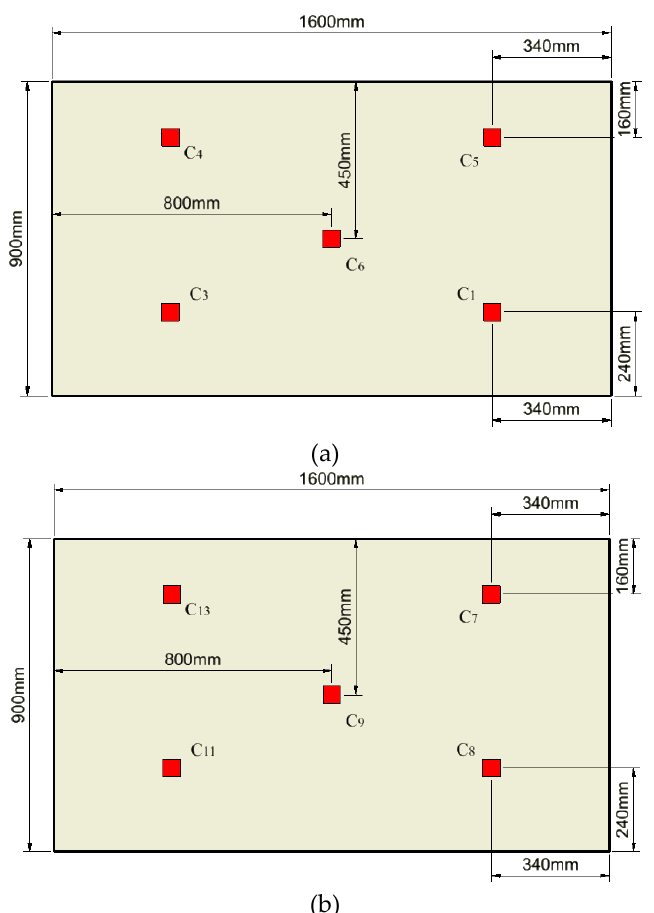
Figure 2. Scheme showing the position of the thermocouples on the right ( a ) and left ( b ) sidewall of the kiln.